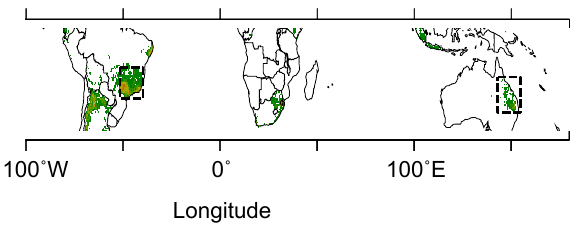
Figure 2. Spatial distribution of the regions (dashed rectangles) used in this study overlaid on a map of the distribution of sugar- cane growing areas indicated in